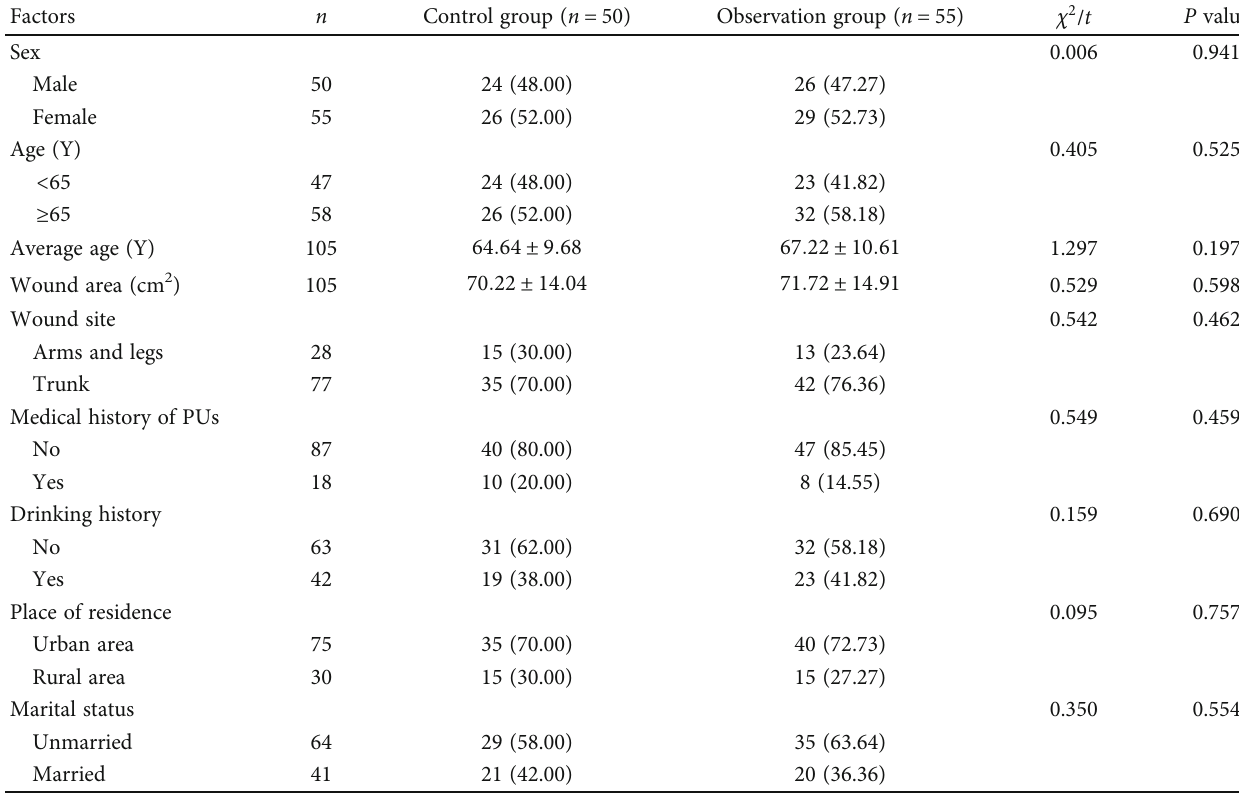
Table 1: Baseline data of the two groups [ n (%), mean ± SEM ].